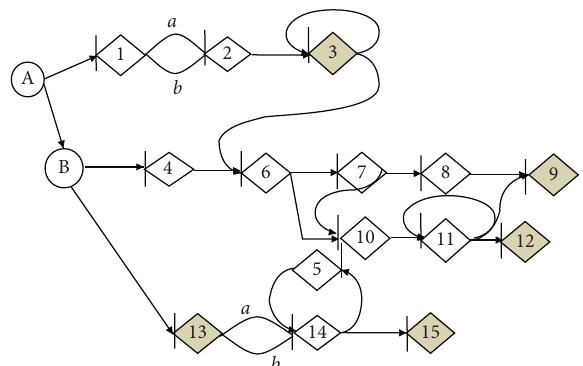
Figure 1: The route map of emergency logistics distribution center delivering materials to material distribution sites around the disaster site. Table 1: The network diagram of the meaning of each site activity. Activity